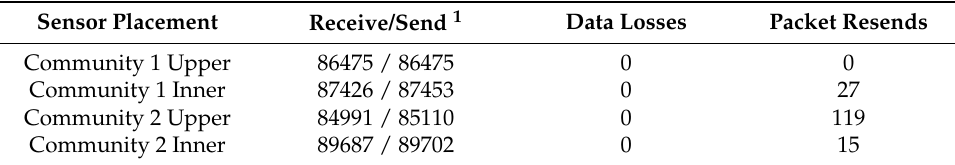
Figure 12. Sensor position for system evaluation. Table 2. Data losses and packet resends of system prototype.